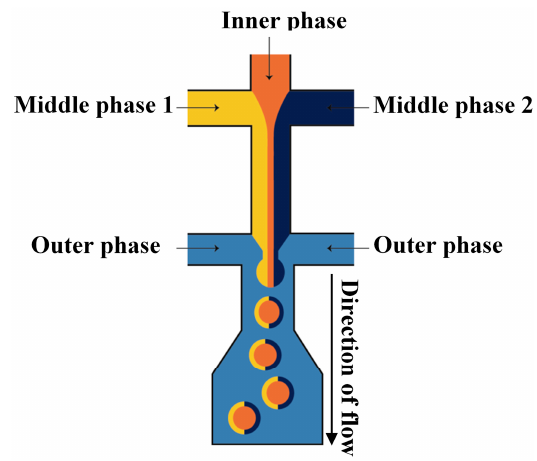
Figure 28. Two sequential cross junctions for generation of single drops surrounded by Janus microshells. The inner fluid forms the core of the droplets, whereas the left- and right-flowing middle fluids form a Janus-shaped shell [113].